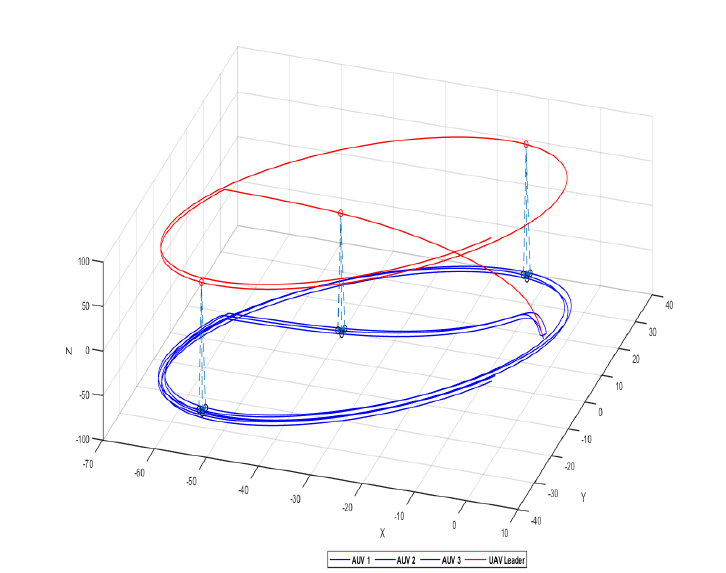
Figure 4. The formation control of three AUVs in triangle form with their UAVs leader under disturbance and uncertainty in 2D space.